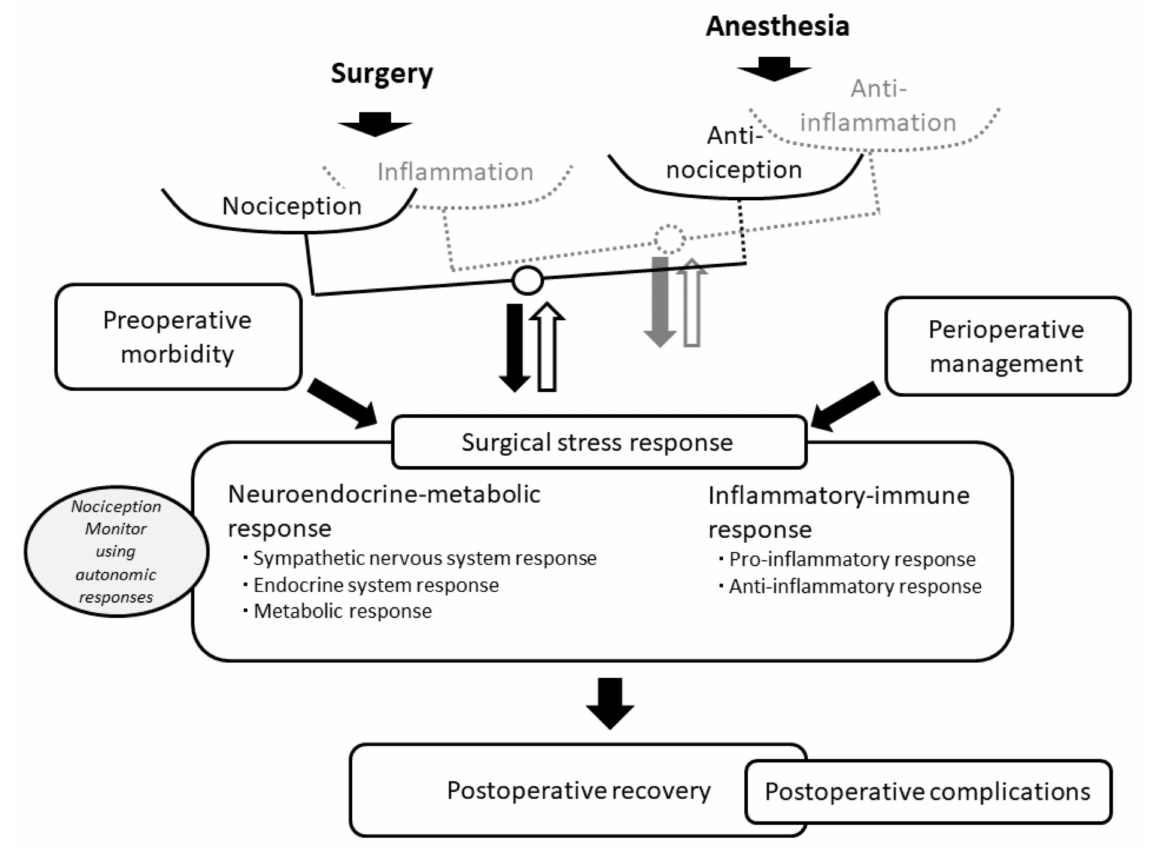
Figure 1. Values assessed by nociception monitors during surgery under general anesthesia. The degree of balance between nociception caused by surgical trauma and anti-nociception provided by anesthesia affects surgical stress responses, consisting of both neuroendocrine-metabolic and inflammatory-immune responses. The degree of balance between inflammation caused by surgical trauma and anti-inflammation due to anesthetic management, preoperative morbidity, and periop- erative management (e.g., ERAS, prehabilitation) also affect surgical stress responses. On the other hand, the balance between nociception and anti-nociception receives feedback regulation from the descending pain inhibitory pathway and baroreflex function (white arrow with black outline). The balance between inflammation and anti-inflammation also receives feedback regulation from the endocrine response (e.g., cortisol) (white arrow with gray outline). The surgical stress response plays a role in sustaining patient homeostasis and supporting postoperative recovery. An excessive degree of surgical trauma and preoperative morbidity, however, exacerbates surgical stress responses, potentially causing postoperative complications. Nociception monitors using autonomic responses (e.g., ANI, SPI, NoL, NR, PPI) represent different aspects of intraoperative surgical stress, in addition to the balance between nociception and anti-nociception. ANI; analgesia nociception index, ERAS; enhanced recovery after surgery, NoL; nociception level, NR; nociceptive response, PPI; pupillary pain index, SPI; surgical pleth